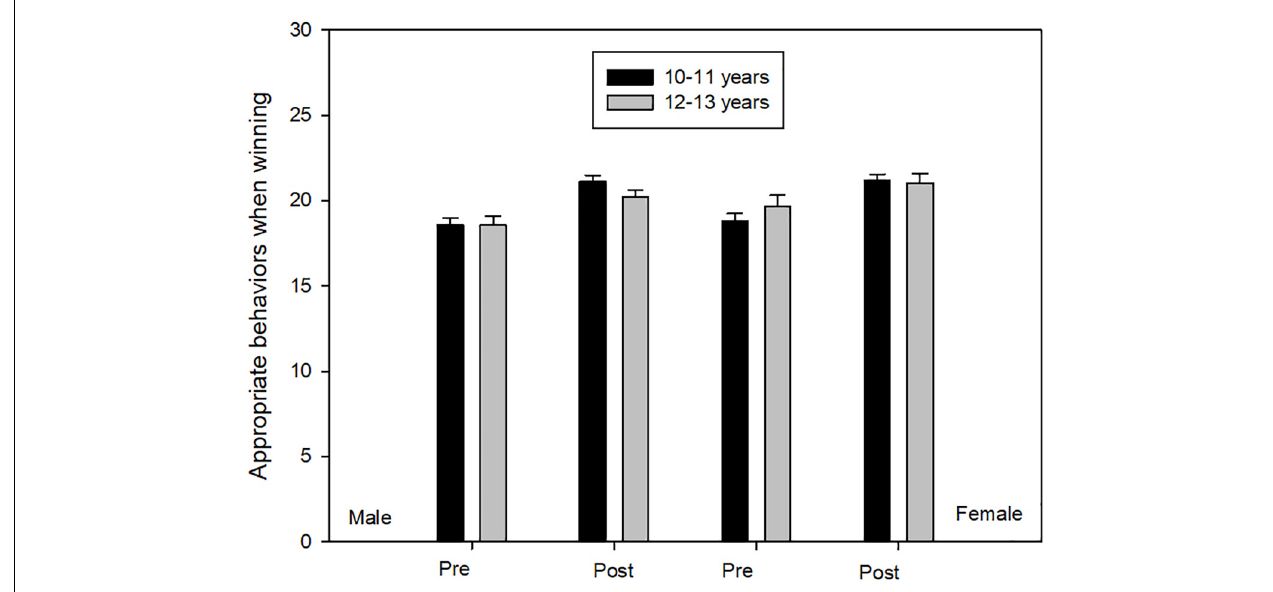
FIGURE 2 | Appropriate behaviors when winning.